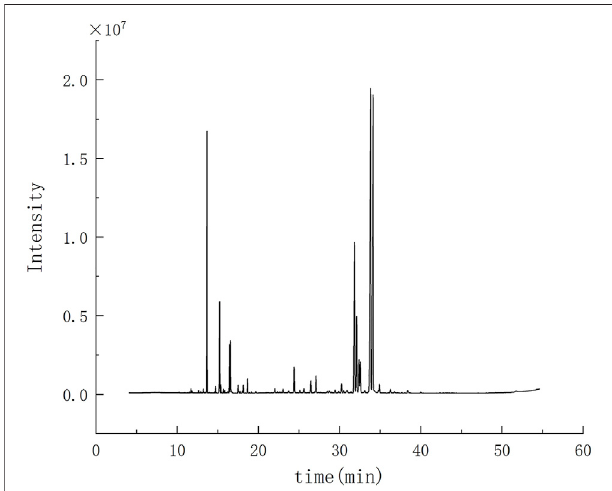
FIGURE 1 | GC-MS chromatogram of MVO extracted from the bark of M. of fi cinalis Rehd. et